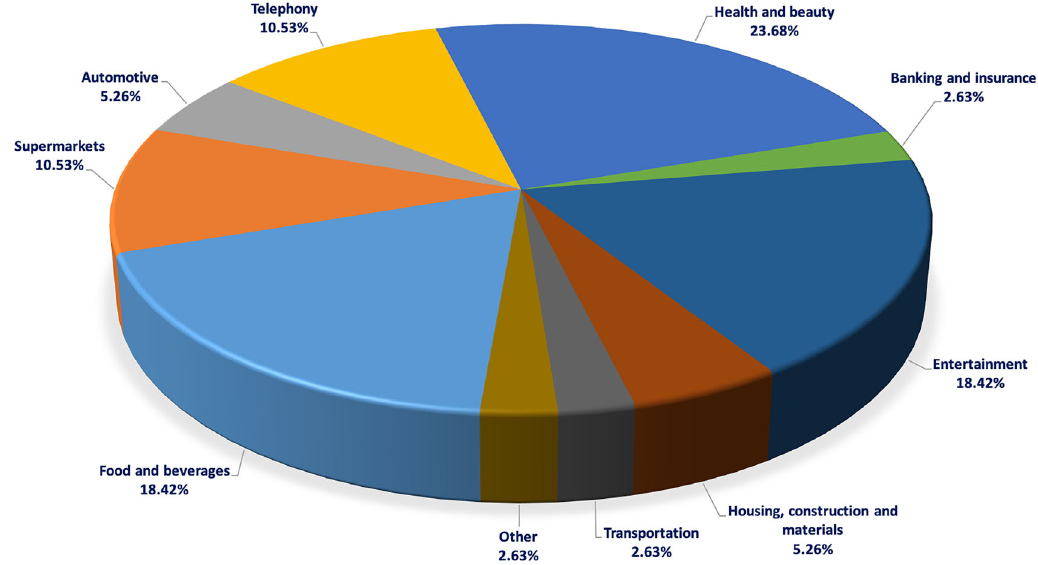
Figure 2. Weighting of each sector in the sample of advertisements for the years 2010-2021. Source: Own elaboration.